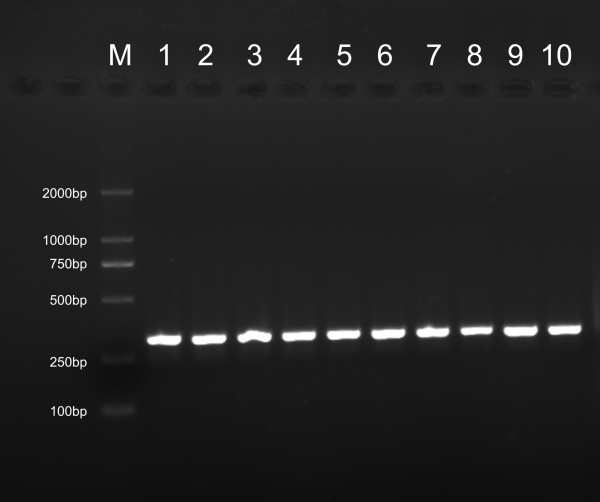
Electrophoresis of single-stranded PCR products. All the nucleic acids were stained by SYBR Green II. The marker was lightly stained, whereas the optical density of ssDNA band was relatively high. Lane 1 and 2: C. perfringens, lane 3 and 4: C. tetani, lane 5 and 6: P. aeruginosa, and lane 7 and 8: S. aureus in duplicates. Plasmid of P. aeruginosa (lane 9), and S. aureus (lane 10) were used to identify the length of ssDNA.